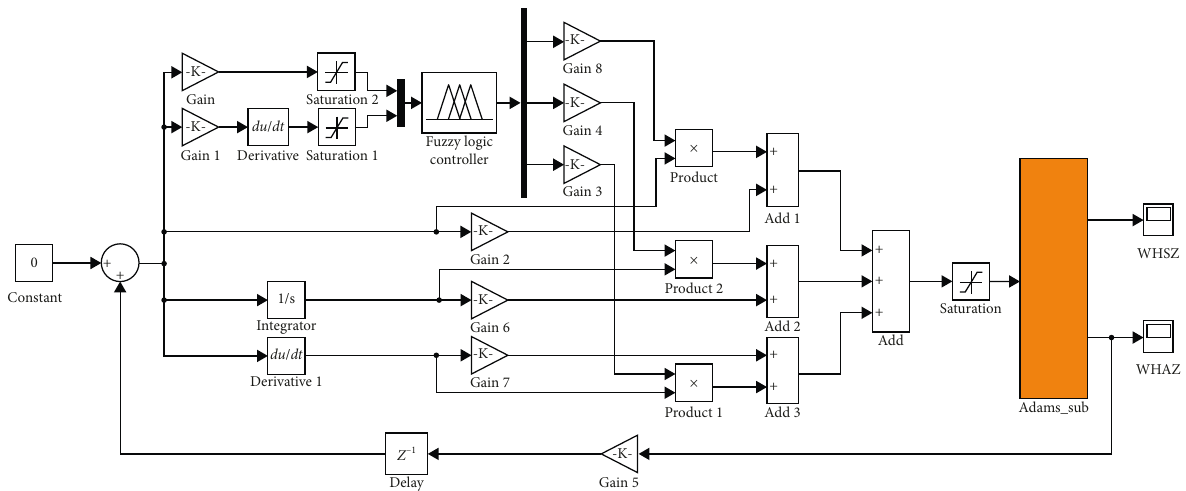
Figure 9: Cosimulation of active control of multistage gear transmission system based on AFPID control.